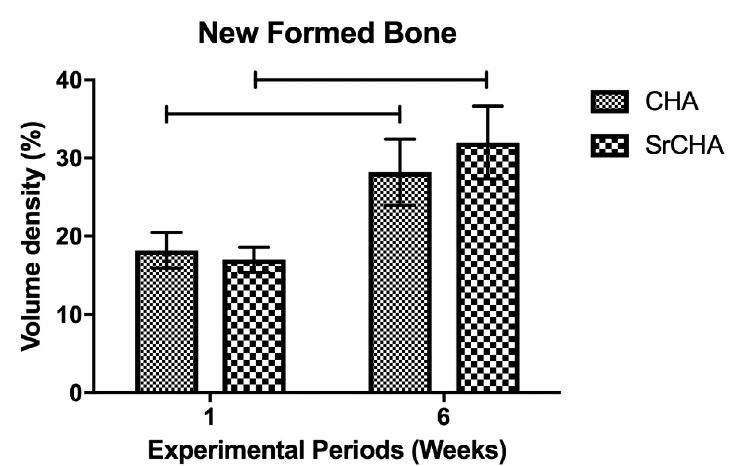
Figure 7- Volume density of newly formed bone. The quantity of newly formed mineralized tissue was similar in both groups in both experimental periods. However, we observed more newly formed bone at 6 weeks than at 1 week. The horizontal lines between bars indicate significant differences between groups (p<0.05). Results are shown as mean percentages ± confidence interval (vertical